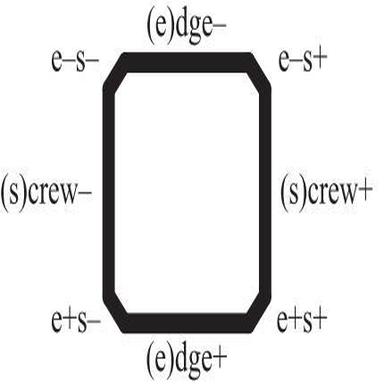
Parametrization of the dislocation loop used to define state variables.